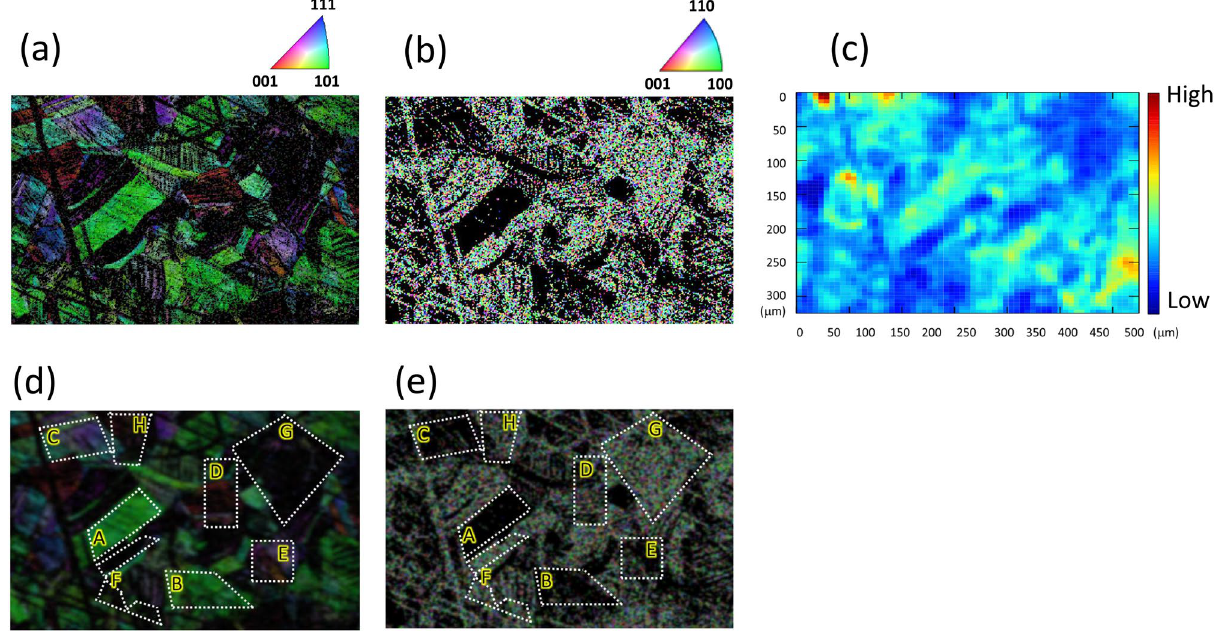
Figure 2. ( a ) Inverse pole figure (IPF) map for austenite in a sample of cold-worked SUS304 stainless steel. ( b ) Inverse pole figure map for martensite at the same position as ( a ). The colours in the IPF maps represent the crystal orientation when viewed from the normal direction (ND), shown in each upper right. ( c ) Distribution of hydrogen permeating through the sample. The colour bar indicates the hydrogen ion counts at each position. The ion counts were integrated over 65 h from the time that hydrogen was first introduced to the bottom of the sample. ( d , e ) Regions A to H (shown in dotted frames) from which characteristics were extracted. For clarity, they are overlaid on the EBSD images of ( b ) and ( c ), respectively. The sizes of each region A–H and the percentages of martensite in them are shown in Supplementary Table